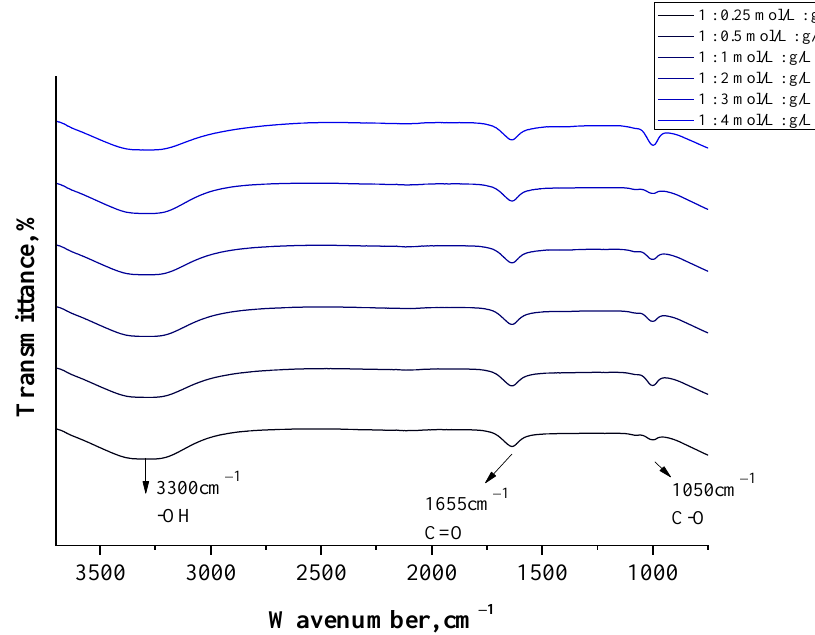
Figure 9. FT-IR spectra of particles obtained using a burette (at various albumin concentrations). In the case of all tested samples, a wide band in the range of 3500–3000 cm −1 was observed, which may be assigned to the stretching vibrations of the OH groups [44]. Next, the absorption band at approx. 1050 cm −1 was identified on all FT-IR spectra. This band probably derives from the stretching vibrations of the C-O group [45]. Particular attention was paid to the bands within the range 1700–1500 cm −1 . This is the region in which, in the case of proteins, absorption bands related to their secondary structure are expected [46].